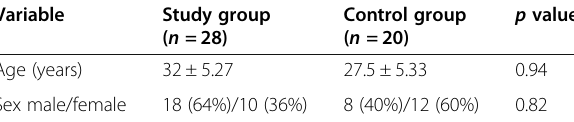
Table 1 Epidemiologic data in both study and control